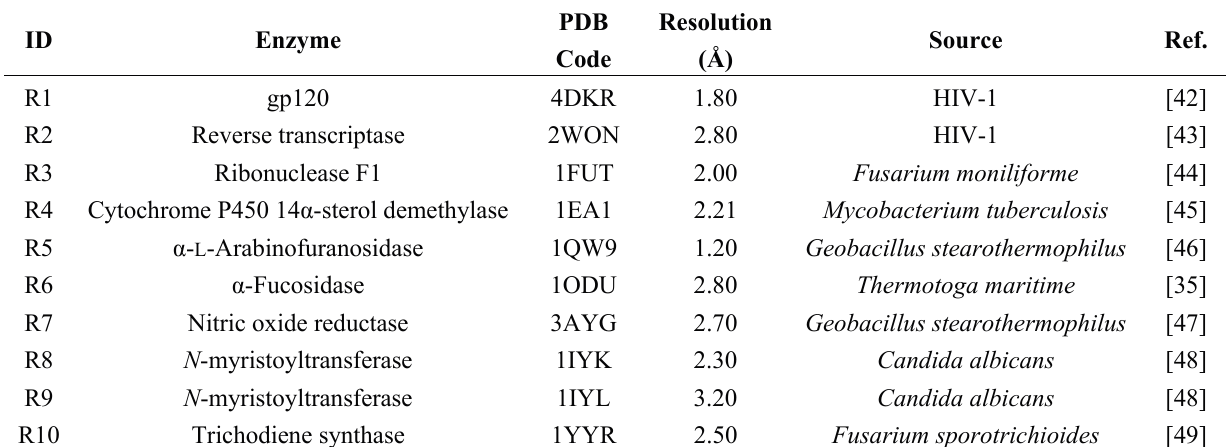
Table 1. Tested receptor data.